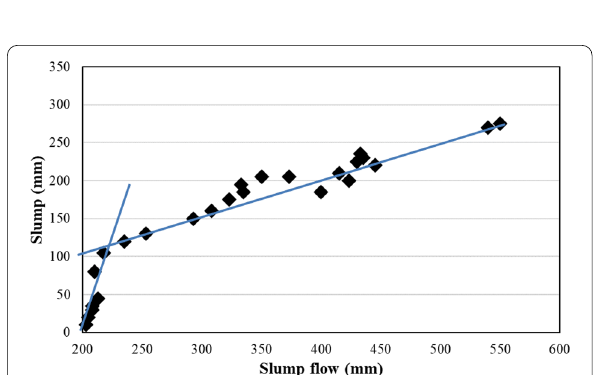
Fig. 17 Relationship between slump and slump flow for normal concrete